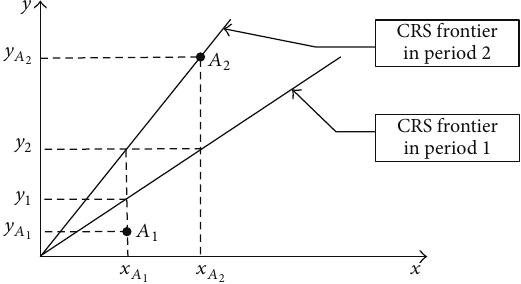
Figure 1: Malmquist productivity index